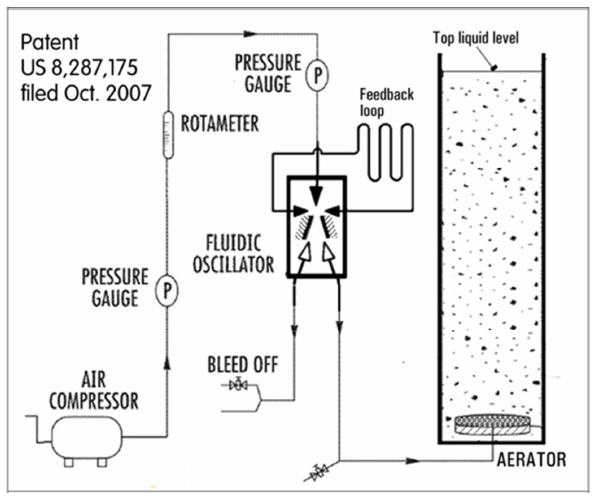
Figure 8. Adapted drawing from the patent document [2] shows the oscillator applied to agitating air flow into a simple bioreactor, a liquid-filled vertical cylinder with transparent walls and the aerator at its bottom. The air bleed off, an obvious energetic loss, was initially necessary for pressure matching. The result of the fully matched adjustments, without the lost air flow, is configured with two reactor vessels operated in anti-parallel (suction on one side at the same time as the output flow on the opposite side) as shown in Figure 9.